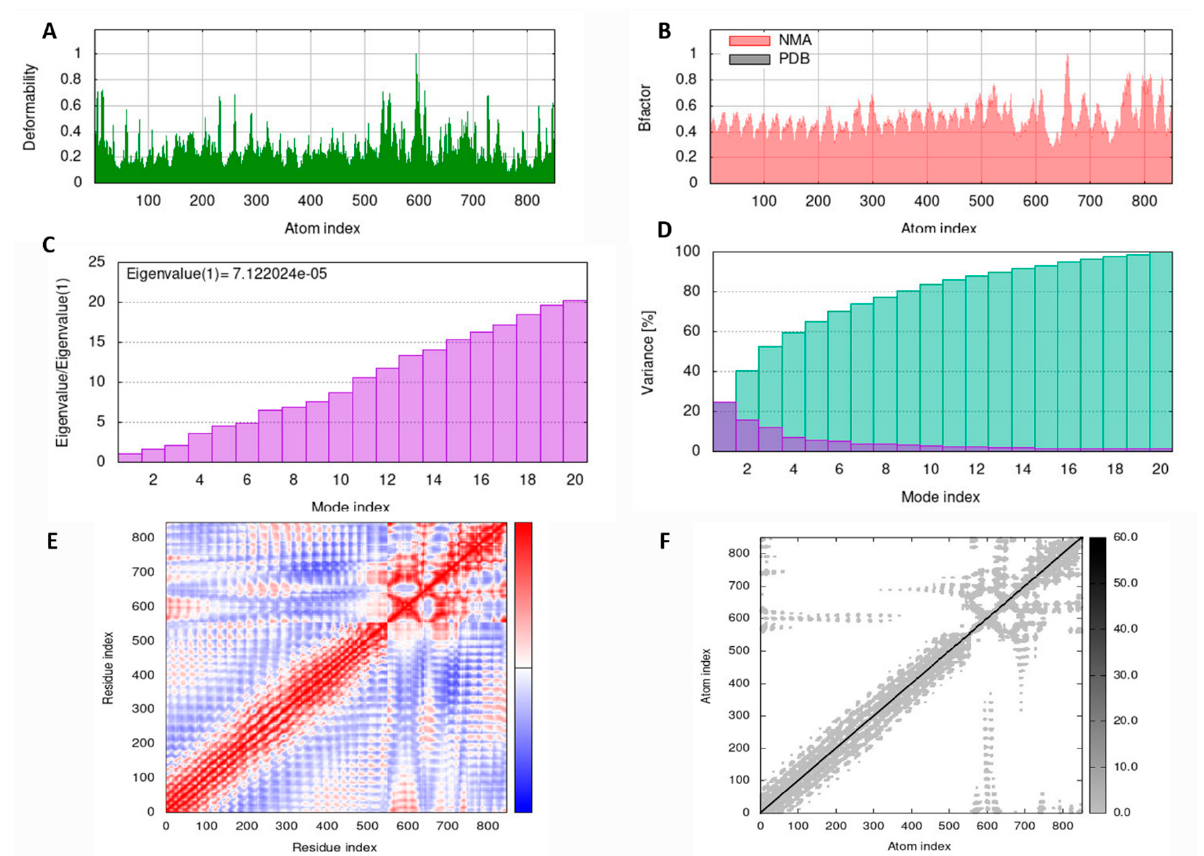
Figure 5. MD simulation results of LSDV-V2 and TLR4 complex obtained by iMODS server. ( A ) deformability ( B ) NMA mobility ( C ) eigenvalues ( D ) purple in the bar shows the individual variances and green depicts cumulative variances ( E ) Covariance map specifies correlated (red), uncorrelated (white), and anti-correlated (blue) motions of paired residues and ( F ) The elastic network model (grey regions indicate sti ff er regions).